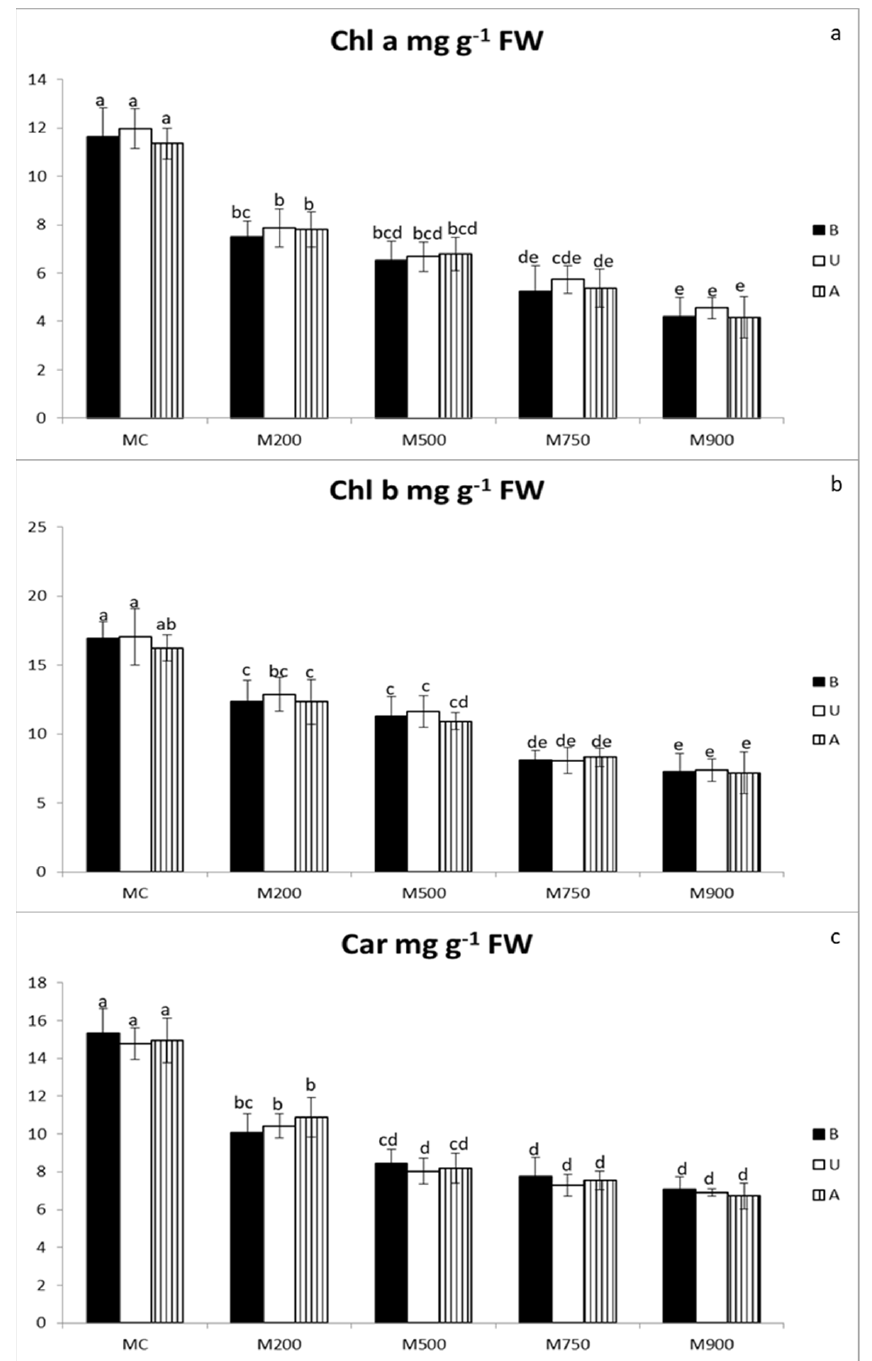
Figure 2. Chlorophyll a ( a ), chlorophyll b ( b ), and carotenoid ( c ) content in the leaves of three different miscanthus cultivars (B, U, and A) cultivated in soils with gradient TE concentrations (MC, M200, M500, M750, and M900). Values are presented as means ± SD. Different letters refer to significant differences between plants (Turkey HSD test, n = 5, p ≤